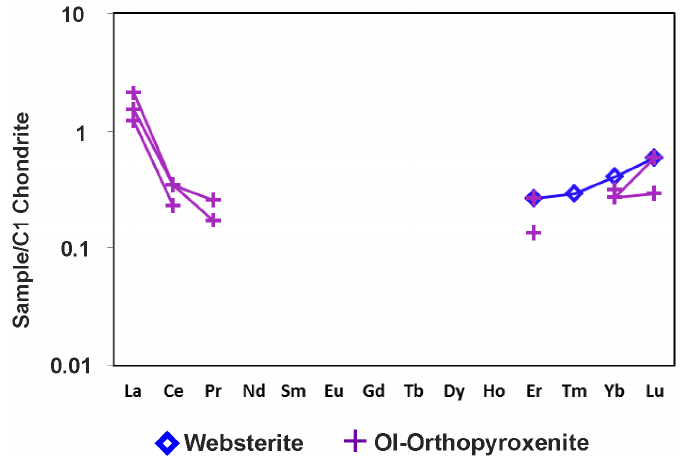
Figure 7. Chondrite-normalized REE patterns of the analysed pyroxenites. Normalising values are after [46].